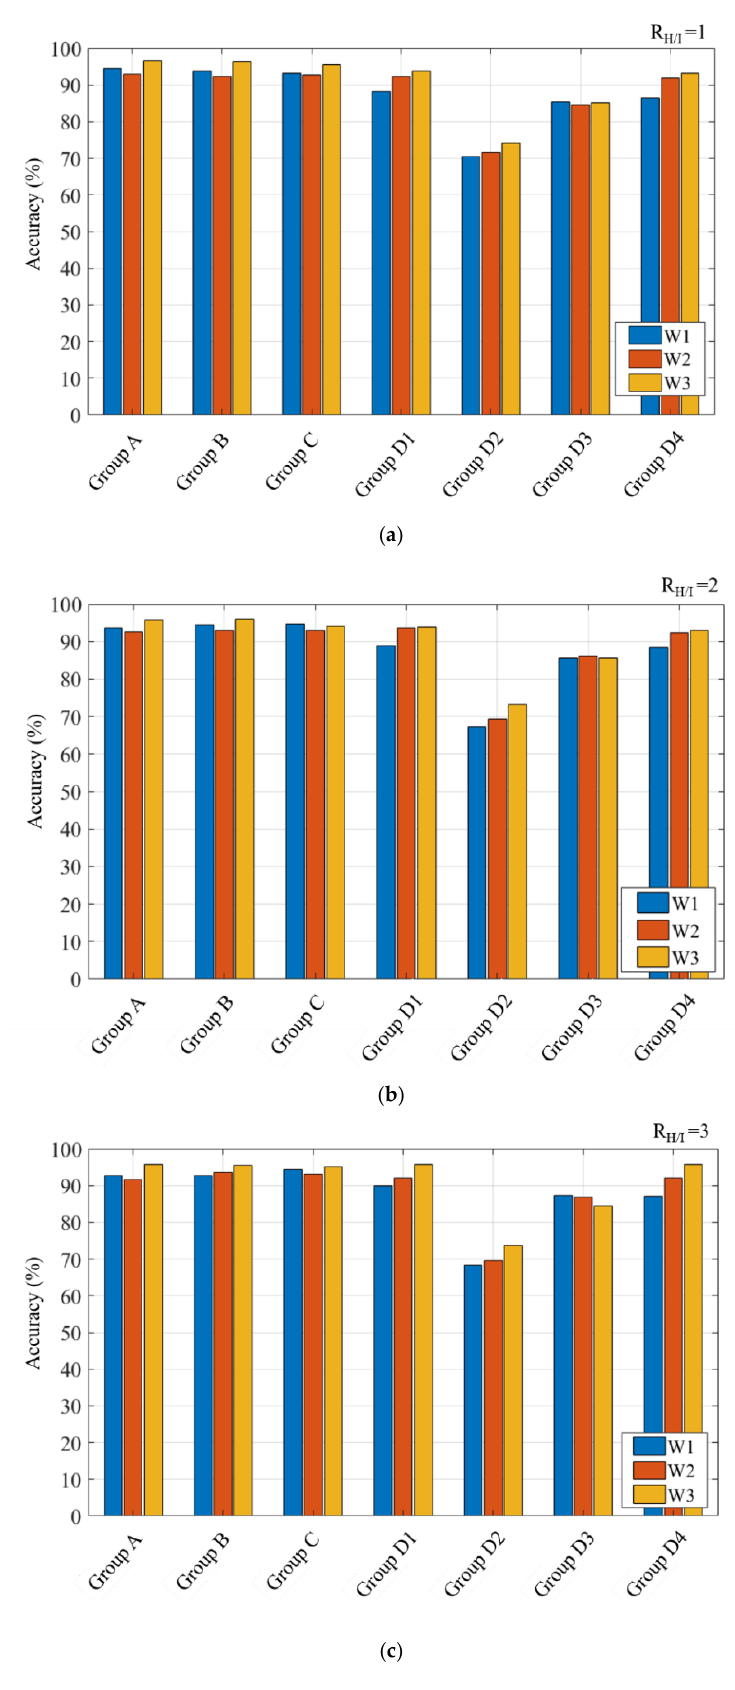
Figure 15. Comparison of the training accuracy when: ( a ) R H / I = 1, ( b ) R H / I = 2, and ( c ) R H / I =